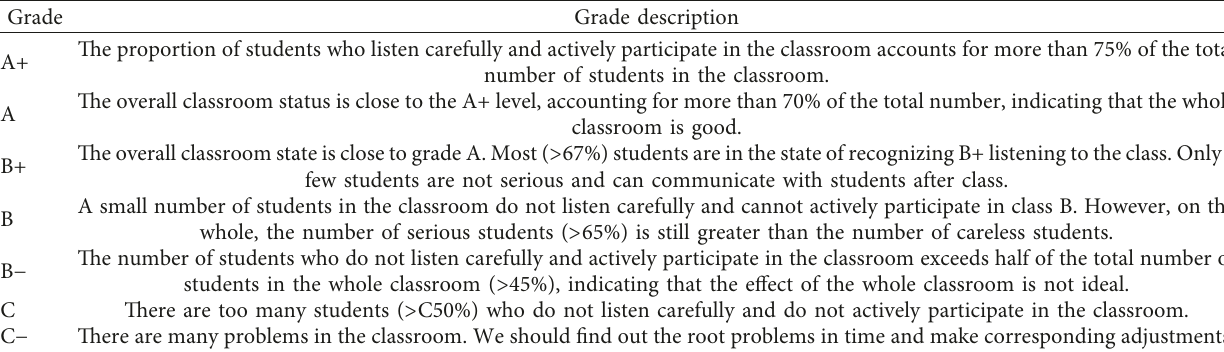
Figure 3: Process of scale transformation of the feature map. Table 2: Grade evaluation form.